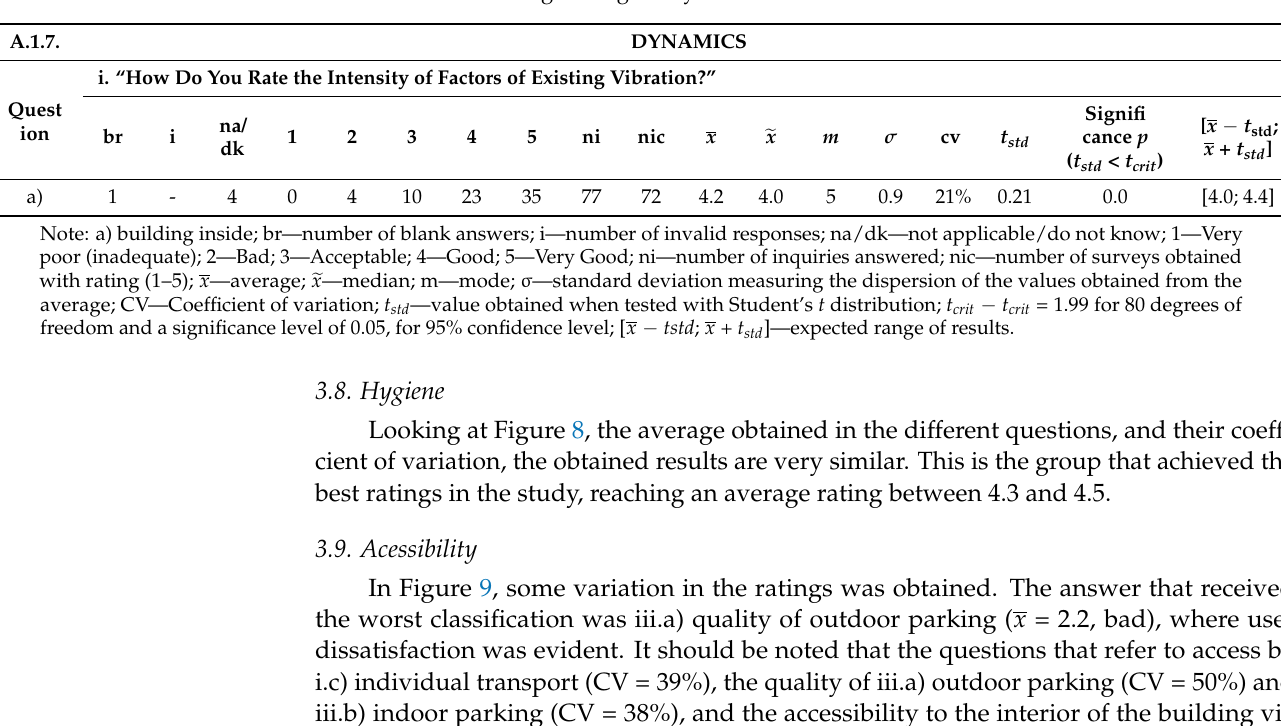
Table 2. Average ratings of